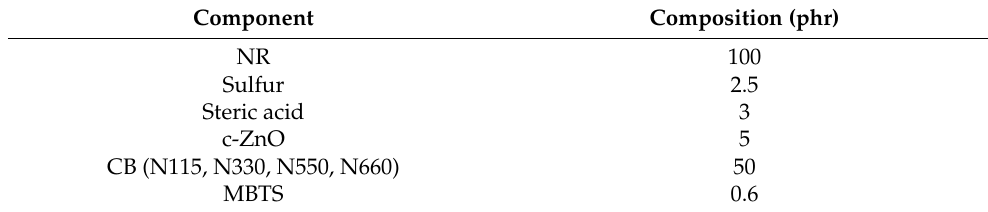
Table 1. Formula of the CB-filled NR compounds.